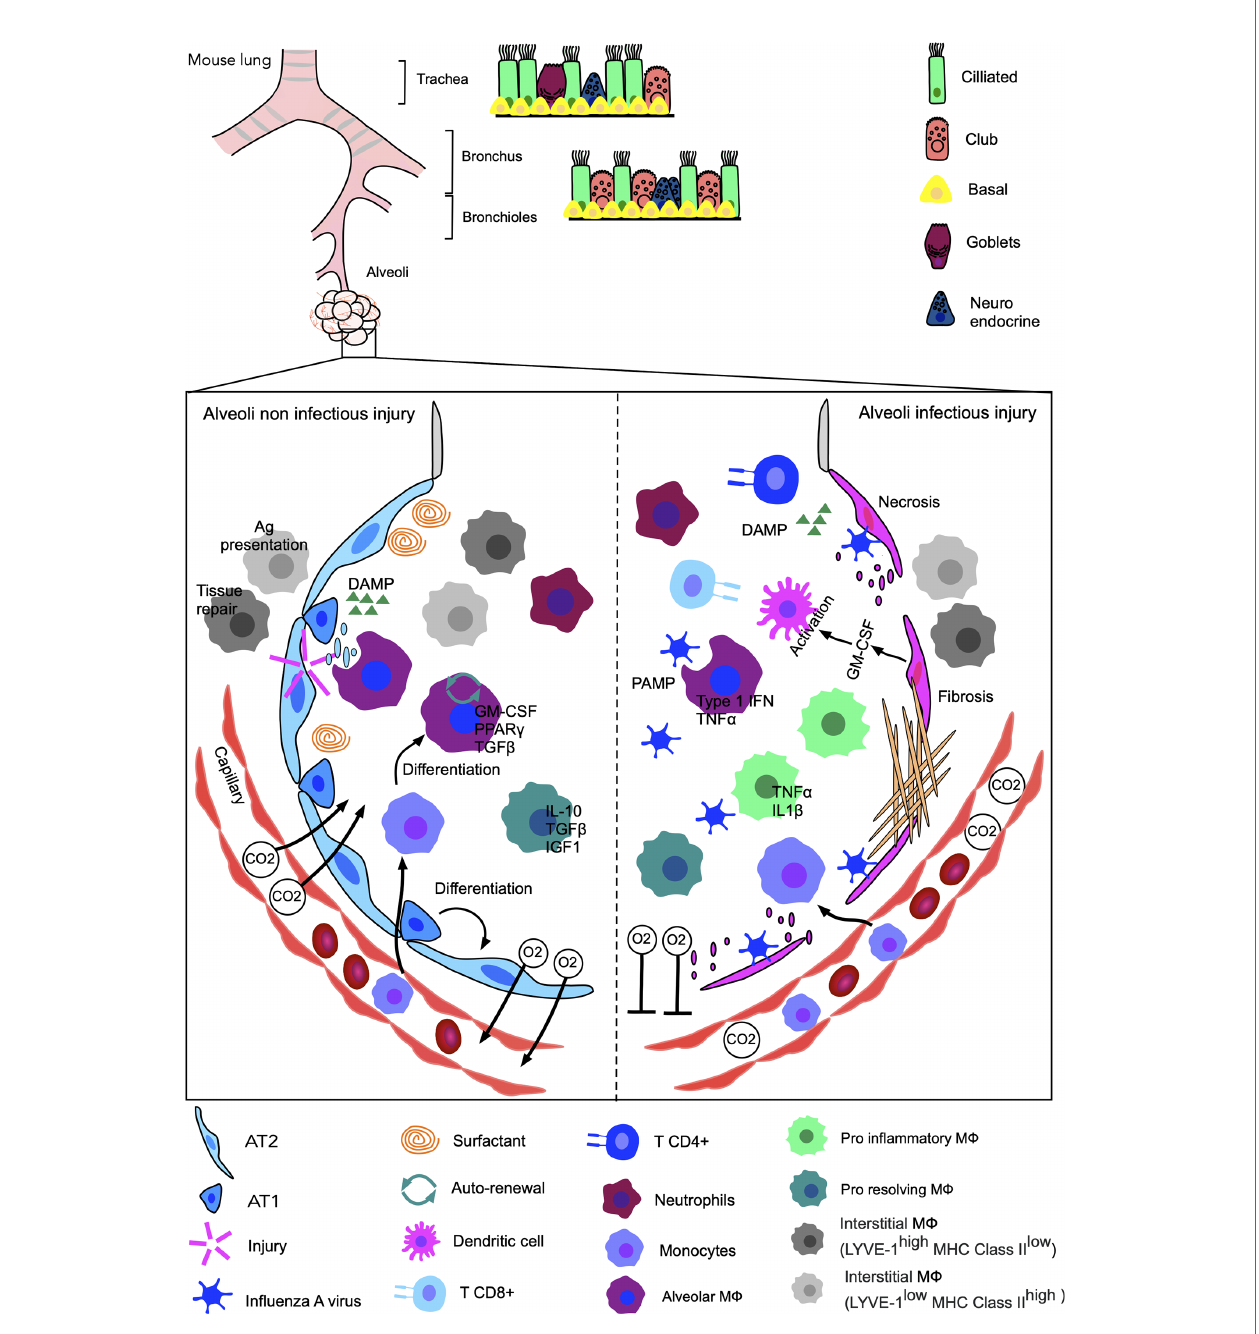
FIGURE 2 | Non-infected versus infected injuries of the murine lungs. The release of DAMPs linked to a sterile induced-injury (ventilator-induced, acid aspiration, contusion, bleomycin injection, resection) in the pulmonary alveolus triggers an immune response consisting primarily of neutrophils and M Ф , resulting in regeneration of the pulmonary epithelium. Alveolar M Ф (GM-CSF, PPAR- g and TFG- b ), the fi rst barrier to danger, phagocytose debris and dead cells. They prevent excessive in fl ammation, the formation of lesions and regulate surfactant. They can self-renew or be substituted by monocyte-derived M Ф . The two types of interstitial M Ф , located in part between the pulmonary epithelium and blood capillaries, enter the alveoli and help the alveolar M Ф to respond to dangers. LYVE-1 low MHC Class II high M Ф are responsible for antigen presentation while LYVE-1 high MHC Class II low help tissue repair. Upon tissue restoration, exchanges of O 2 and CO 2 through the capillaries return to normal. Injury in infectious conditions, for example caused by infection with In fl uenza A virus in mice, may impair the ability to regenerate. Alveolar M Ф phagocytes debris, dead cells and the infectious agent. Alveolar M Ф initially anti-in fl ammatory, adopt an in fl ammatory phenotype with the release of IFN- g and TNF- a leading to the production of GM-CSF by epithelial cells, in turn activating dendritic cells (DC). Three weeks after infection of M Ф , neutrophils and CD4 + , CD8 + T cells are still present. Excessive in fl ammation with the persistent presence of pro-in fl ammatory M Ф can eventually lead to extensive cell necrosis and the formation of non-functioning fi brous scar tissue. As a result, oxygen is no longer properly transferred to the blood capillaries and breathing dif fi culties may